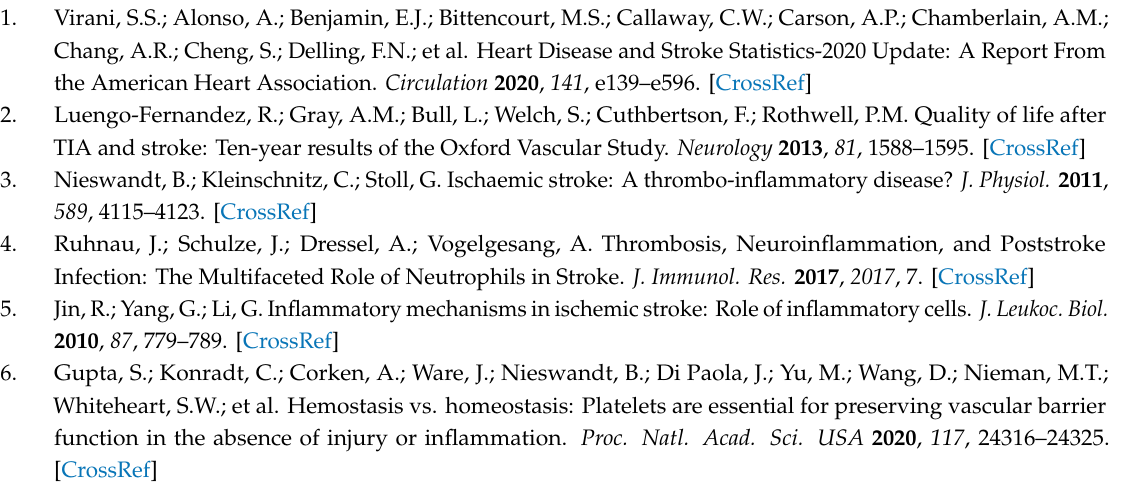
Figure S1: E ff ect of FPR antagonists. Mice (C57BL / 6) were subjected to vehicle LPS (10 µ g / mouse) for 2 h and treated with vehicle (saline), pan FPR antagonist Boc2 (10 µ g / mouse) or FPR2 / ALX antagonist WRW4 (55 µ g / mouse) 20 min prior to light / dye-induced thrombus formation, with time of onset and blood flow cessation times recorded for cerebral (A) arterioles and (B) venules. Data are means ± SEM of 5–6 mice / group. $$$$ p < 0.0001 vs. same group for onset time, Figure S2: Onset and blood flow cessation times in mice with / without endotoxaemia. C57BL / 6 mice or sickle cell transgenic mice (STM) were subjected to vehicle (saline) or LPS (0.4 mg / kg) for 2 h. A cranial window was performed, and FITC-dextran injected (10 mg / kg of 5%).Mice were then subjected to intravital microscopy and light / dye-induced thrombus formation, with time of onset and blood flow cessation times recorded for cerebral (A) arterioles and (B) venules. Data are means ± SEM of 5–6 mice / group. * p < 0.05, ** p < 0.01 vs. C57BL / 6 saline group. ## p < 0.01 vs. STM saline group. $ p < 0.05, $$ p < 0.0001 vs. same group for onset time, Figure S3: AnxA1 Ac2-26 did not a ff ect neutrophil counts in LPS-treated mice. Peripheral blood neutrophil counts were assessed following saline (vehicle) or AnxA1 Ac2-26 (4 mg / kg) administration for 20 min following 2 h saline (vehicle) or LPS (0.4 mg / kg) administration. Data are means ± SEM of 5–6 mice / group. ** p < 0.01, *** p < 0.001 vs. LPS vehicle (saline), Figure S4: E ff ect of FPR antagonists in sickle cell transgenic mice (STM). STM were subjected to vehicle LPS (10 µ g / mouse) for 2 h and treated with vehicle (saline), pan FPR antagonist Boc2 (10 µ g / mouse) or FPR2 / ALX antagonist WRW4 (55 µ g / mouse) 20 min prior to light / dye-induced thrombus formation, with time of onset and blood flow cessation times recorded for cerebral (A) arterioles and (B) venules. Data are means ±